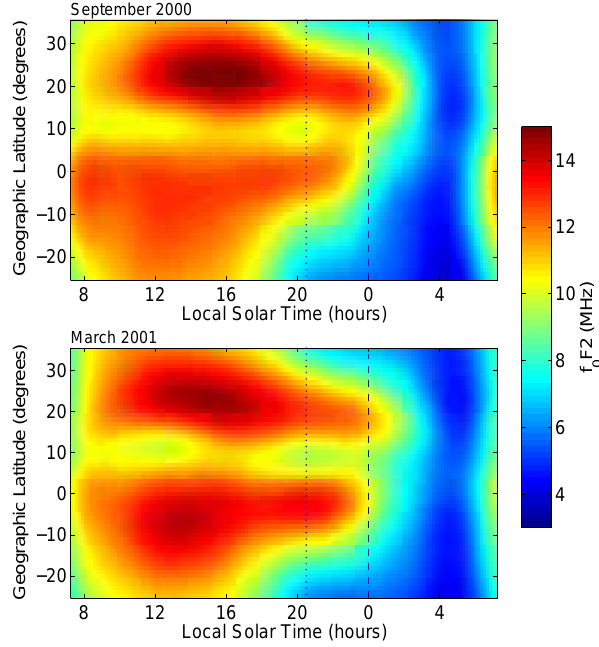
Fig. 7. Critical frequency of the F2 layer at the 110 ◦ meridian as a function of time and geographic latitude generated by IRI90. The dotted line indicates the time when the peak irregularity activity occurs while the dashed line indicates local